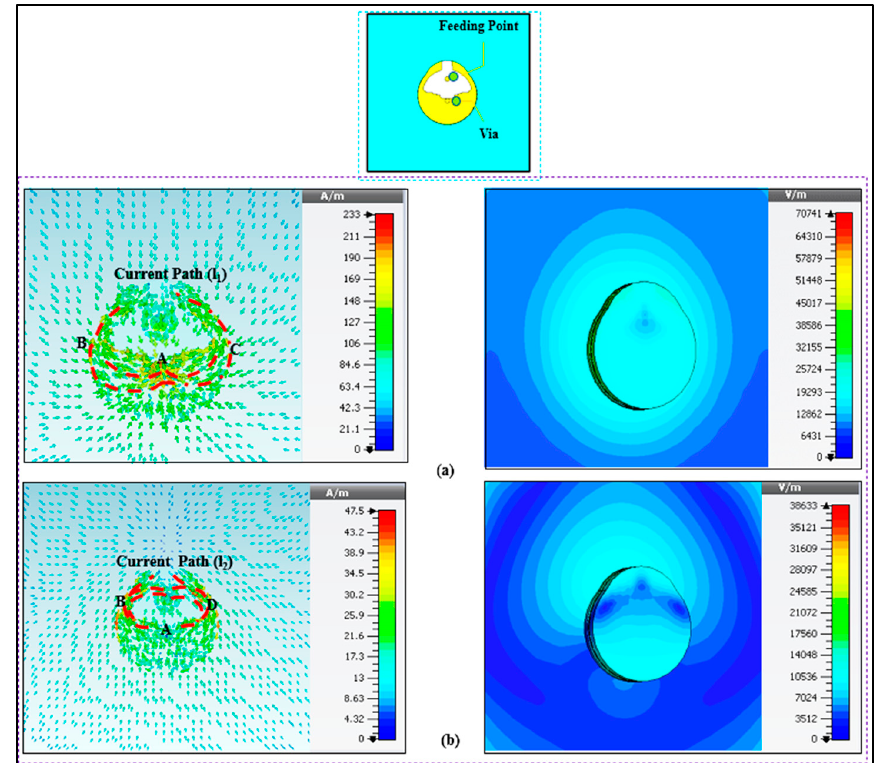
Figure 7. ( a ) Surface current distribution (left side) and magnitude (right side) at lower band 2.45; ( b ) Surface current distribution (left side), and magnitude (right side) at the upper bands at 5.6 GHz. Micromachines 2022 , 13 , 475